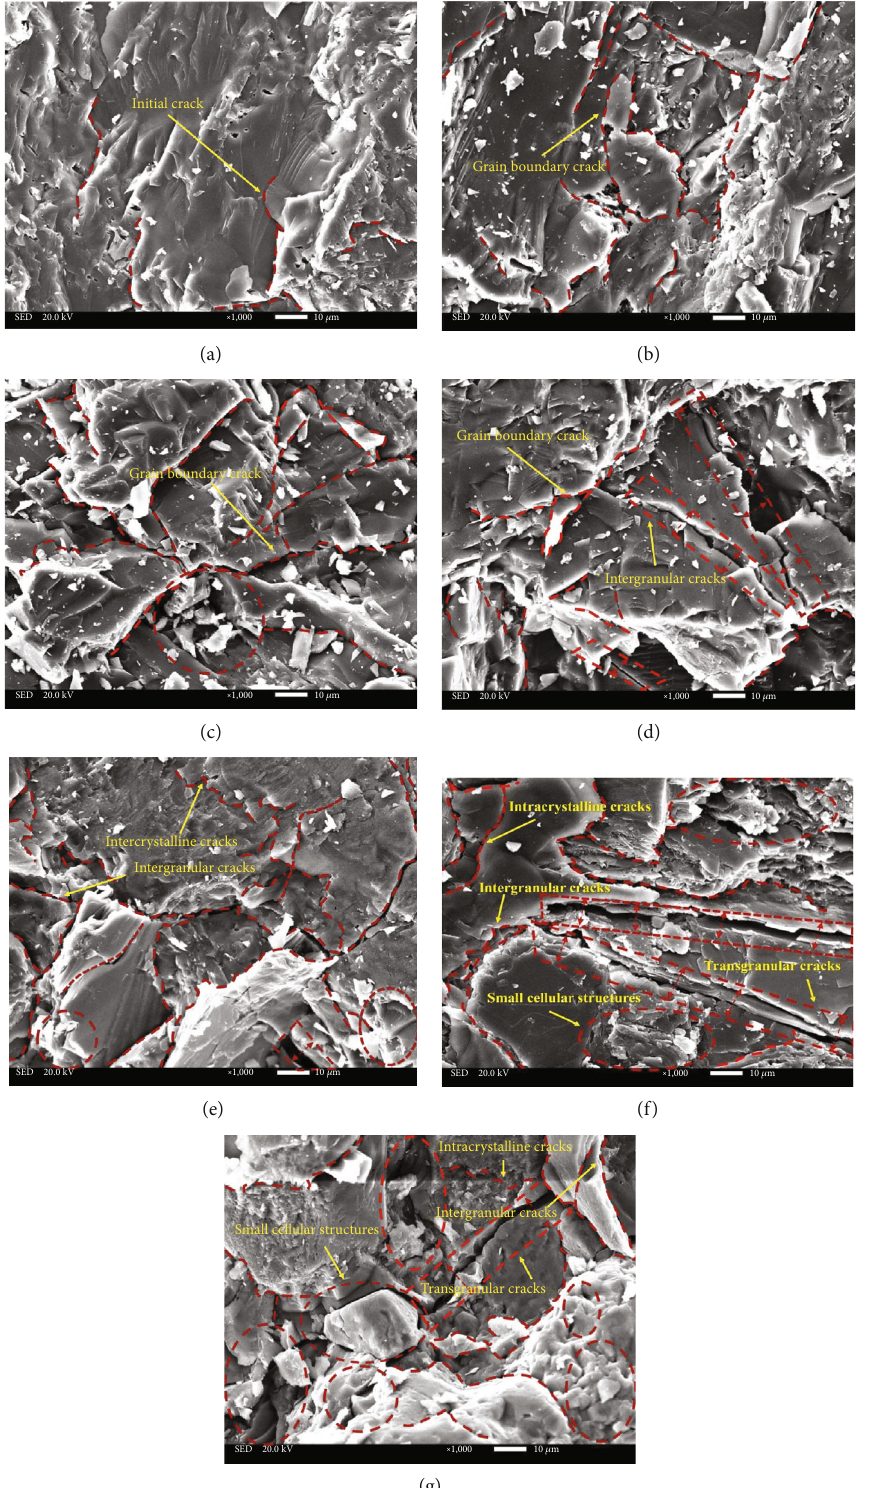
Figure 3: SEM images of the granite fracture surface at di ff erent real-time high temperatures: (a) 25 ° C; (b) 200 ° C; (c) 300 ° C; (d) 400 ° C; (e) 500 ° C; (f) 600 ° C; (g) 700 °